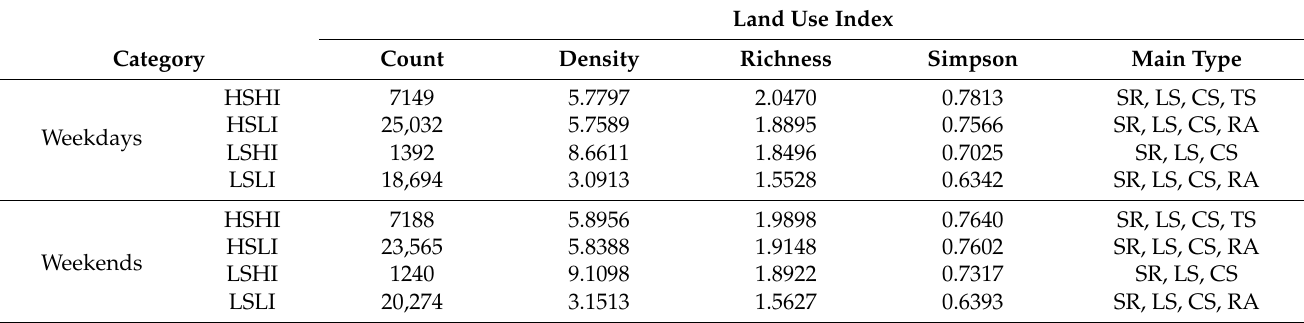
Table 3. Land use characteristics of street